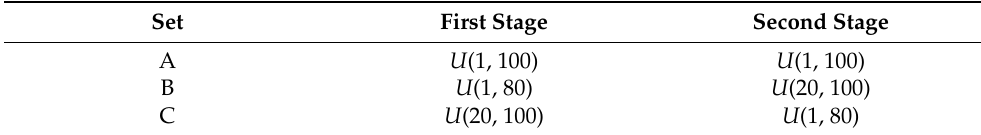
Table 2. Processing time distribution.